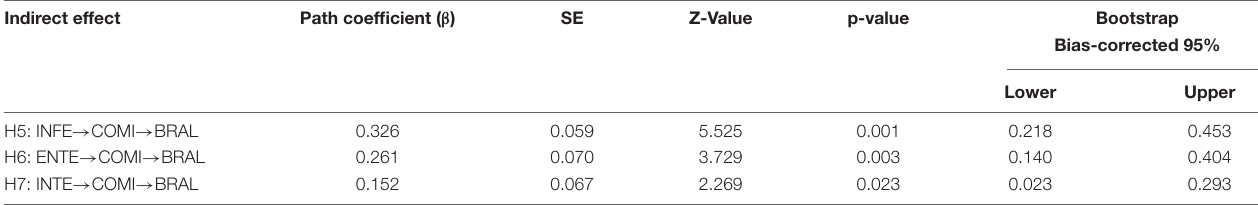
TABLE 6 | The analysis of indirect